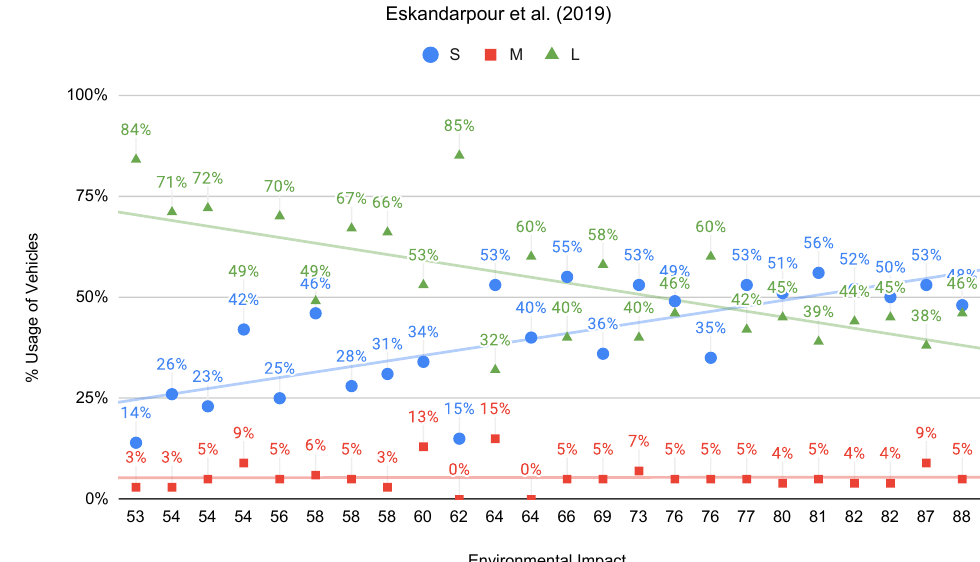
Figure 6. The expected environmental impact according to the percentage usage of each vehicle type of the